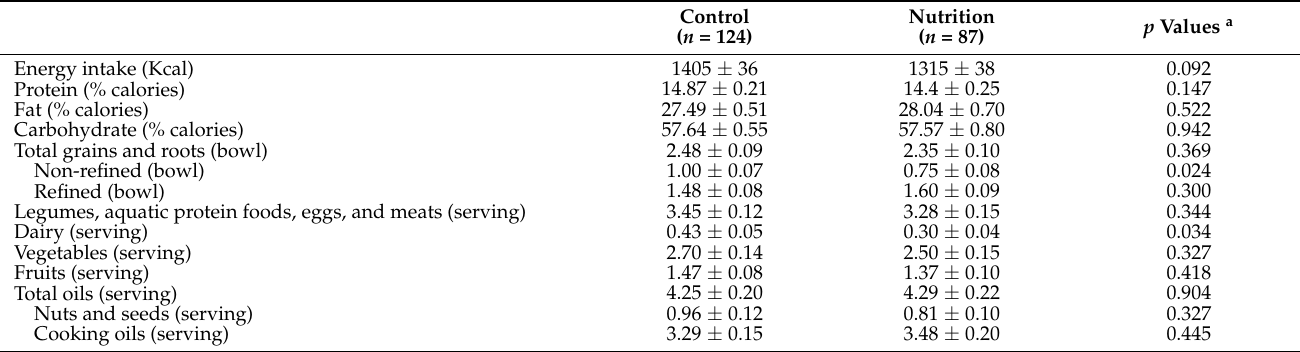
Table 2. Baseline daily dietary intakes of the participants by treatment groups 1 .